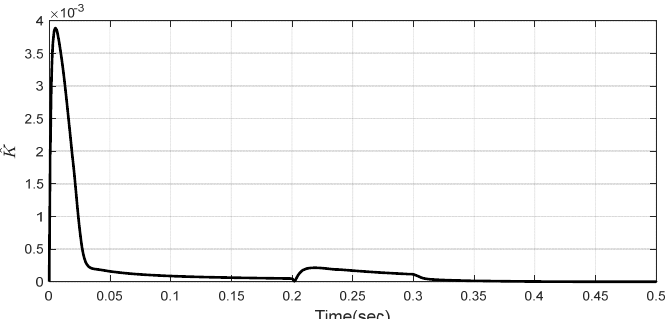
Figure 30. Sliding surface in the presence of measurement noise.